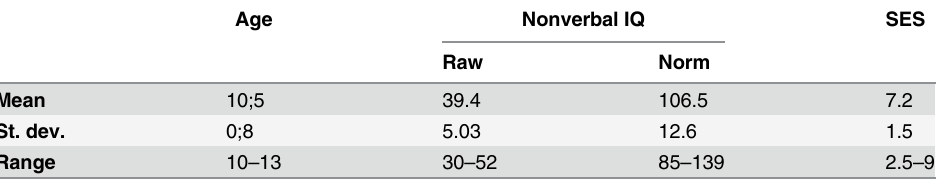
Table 1. Descriptive statistics for children ’ s age, raw and norm scores on nonverbal intelligence (IQ) and socio-economic status (SES).